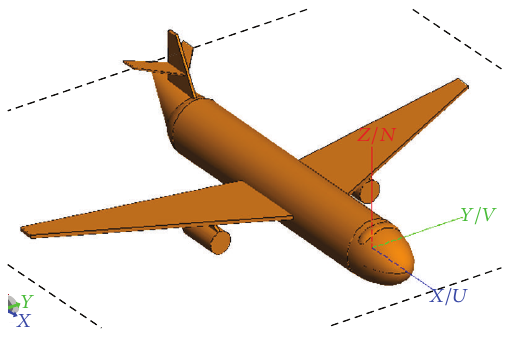
Figure 9: The 3D model of the